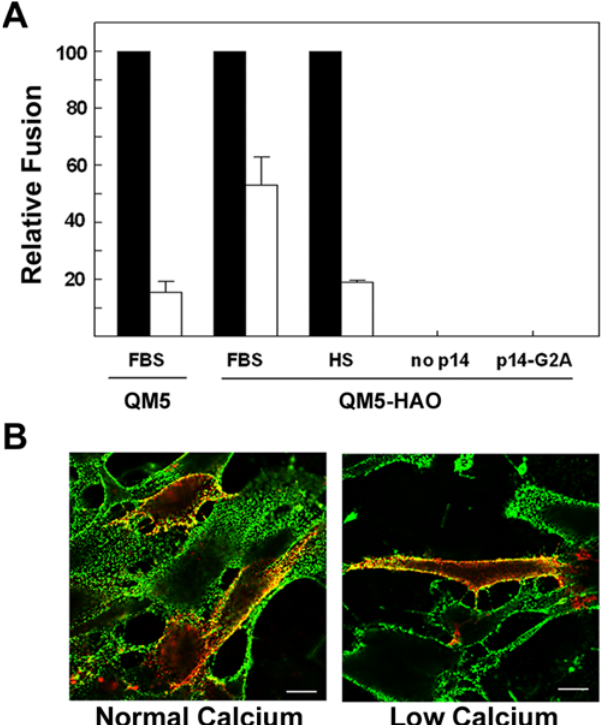
Figure 7. Surrogate receptor binding proteins enhance p14- mediated fusion in the absence of cadherin junctions. (A) QM5 and QM5-HAO cells were transfected with p14 and cell–cell fusion under normal (black bars) or low (white bars) calcium conditions in the presence of FBS was quantified by syncytial indexing at 7 h post- transfection. QM5-HAO cells were also transfected under similar conditions and incubated in the presence of horse serum (HS) to block HAO receptor binding, or were transfected with the non-fusogenic mutant p14-G2A or empty vector (no p14) to assess any contribution of the HAO protein to syncytiogenesis. Data is presented as the extent of fusion under low calcium conditions relative to normal calcium conditions. Values represent the mean 6 S.E. (n=3–5). The average numbers of syncytial nuclei per field under normal calcium levels (i.e. the 100% level) were 151.9 (QM5 cells in FBS), 169.4 (QM5-HA0 cells in FBS), and 51.2 (QM5-HA0 cells in HS). (B) Merged surface immunoflu- orescence microscopy images of epitope-tagged p14 (red) and influenza HA (green) in QM5-HAO cells under normal and low calcium conditions. Yellow indicates regions of p14 and HAO colocalization. Scale bars=10 m